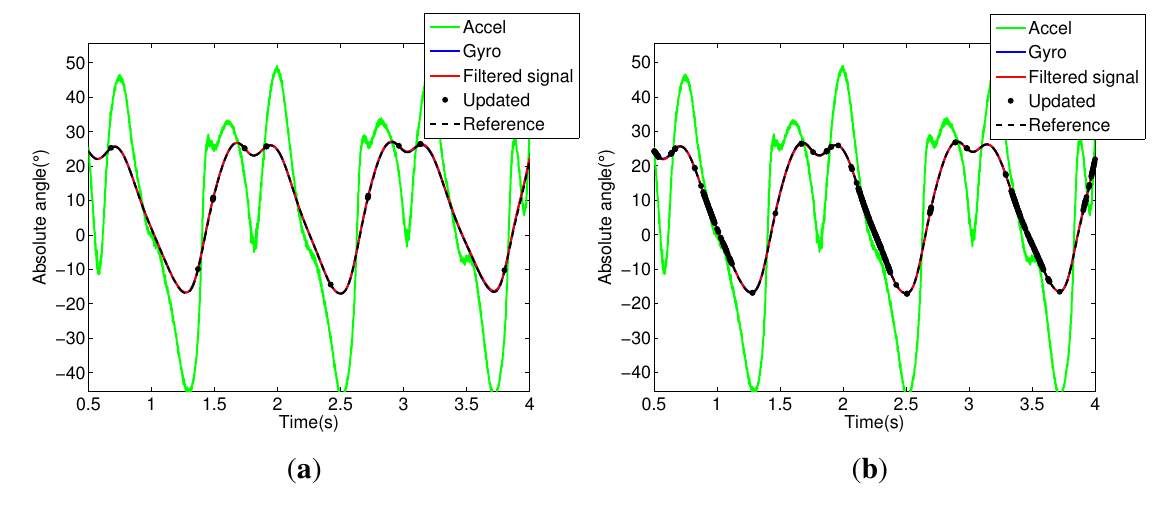
Figure 6. Thigh segment. ( a ) KF signals; ( b ) MKF signals.